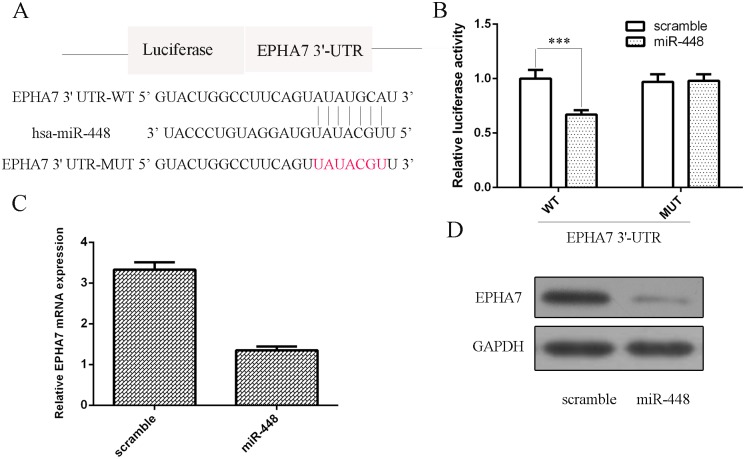
EPHA7 was a direct target gene of miR-448 in osteosarcoma cells.(A) The potential putative gene encoding EPHA7 harbored a miR-448 binding siteis shown. (B) Overexpression of miR-448 caused a decline in the luciferase activity when this reporter gene included the EPHA7 3’UTR in the MG-63 cells. (C) Ectopic expression of miR-448 suppressed EPHA7 mRNA expression in the MG-63 cells. (D) Ectopic expression of miR-448 suppressed EPHA7 protein expression in the MG-63 cells. ***p<0.001.